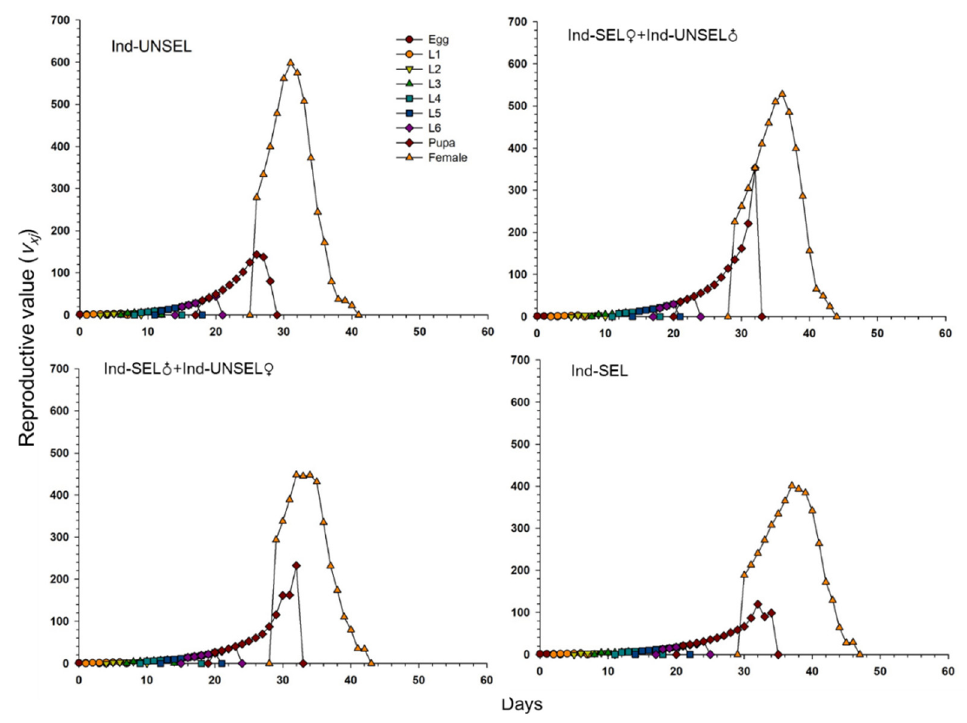
Figure 4. Age-stage specific life expectancy ( e xj ) of Ind-UNSEL, Ind-SEL ♀ × Ind-UNSEL ♂ , Ind-SEL ♂ × Ind-UNSEL ♀ and Ind-SEL population of S. frugiperda.